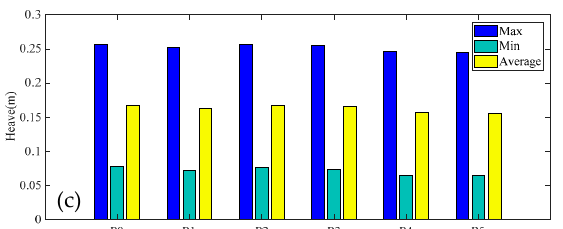
Figure 9. The maximum and minimum values and average values of heave motion from 600 s to 900 s for ( a ) case 1, ( b ) case 2, and ( c ) case 3.